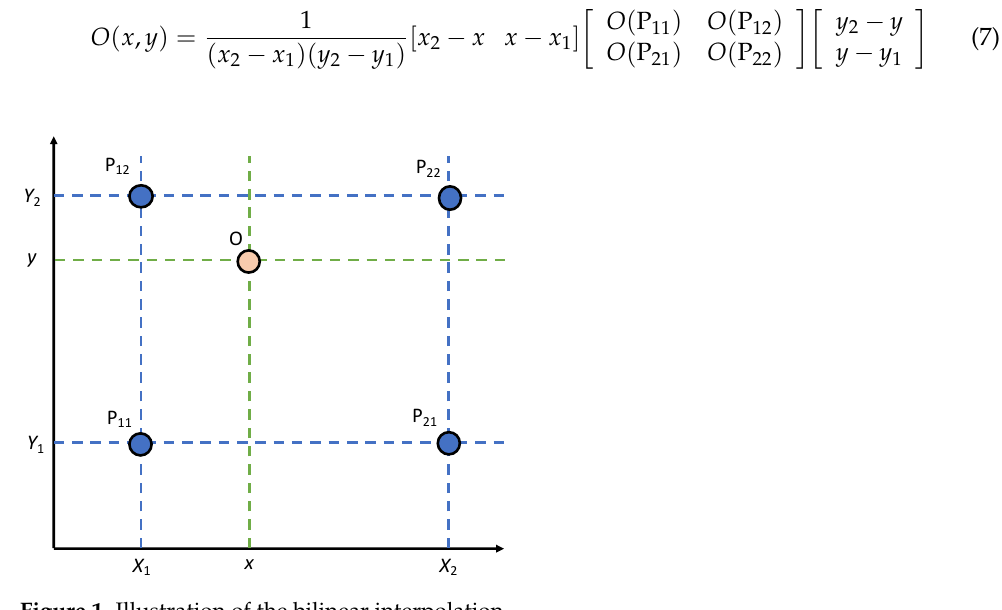
Figure 1. Illustration of the bilinear interpolation.